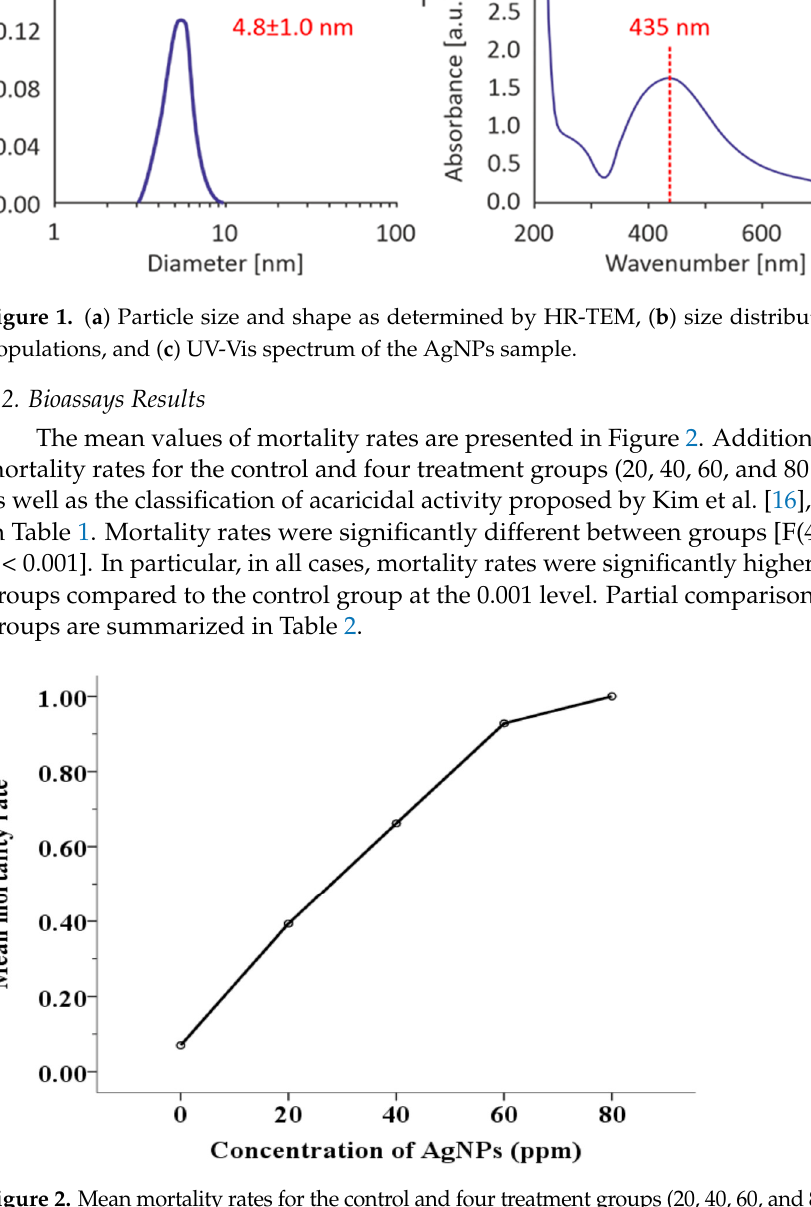
Figure 2. Mean mortality rates for the control and four treatment groups (20, 40, 60, and 80 ppm AgNPs). Table 1. Mean mortality rates for the control and the four treatment groups (20, 40, 60, and 80 ppm AgNPs) after 24 h and classification of acaricidal activity.